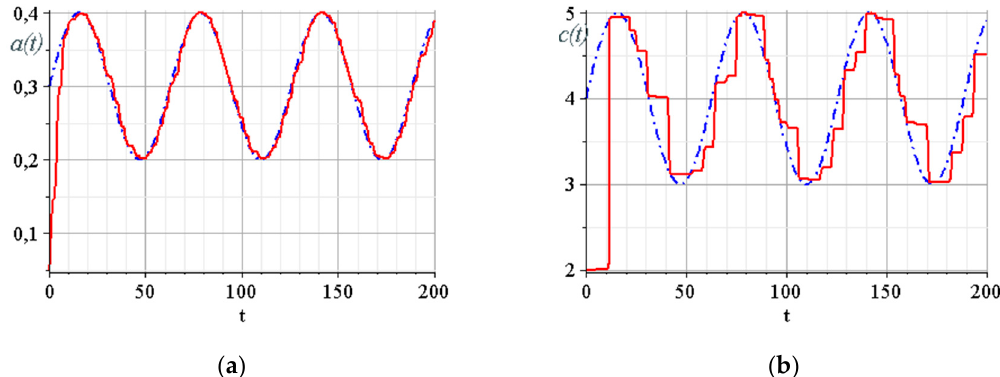
Figure 14. Transmitted signal reconstruction error: ( a ) Signal a reconstruction error; and ( b ) Signal c reconstruction error.